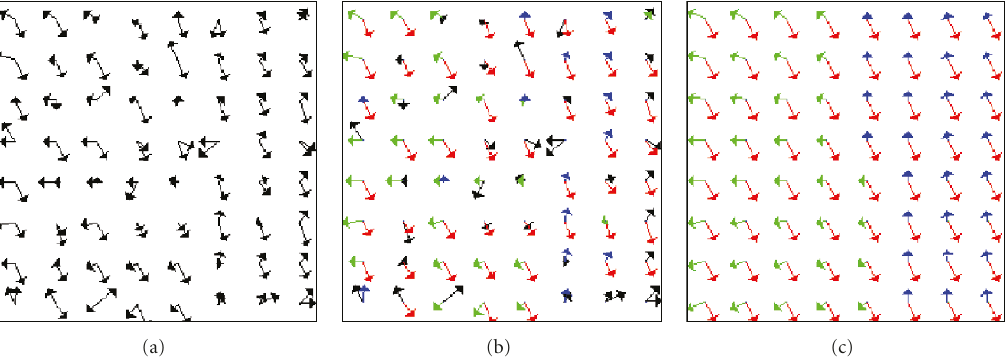
Figure 5: Example if the initialization stage for a symbolic example. (a) The displacements computed by the transparent block-matching. (b) The velocity fields corresponding to the a ffi ne models extracted by the Hough transform. Three layers are detected; they are plotted in red, green and blue. The erroneous displacements are plotted in black. (c) The true